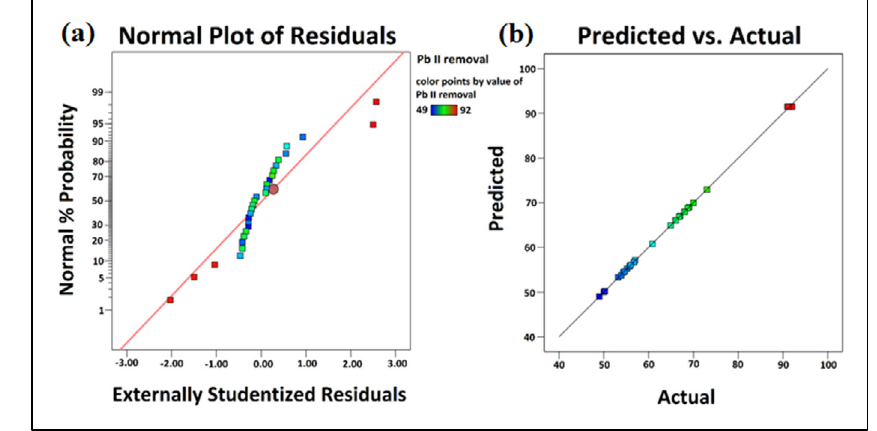
Fig. 7. (a) Normal plot of residuals and (b) predicted vs. actual